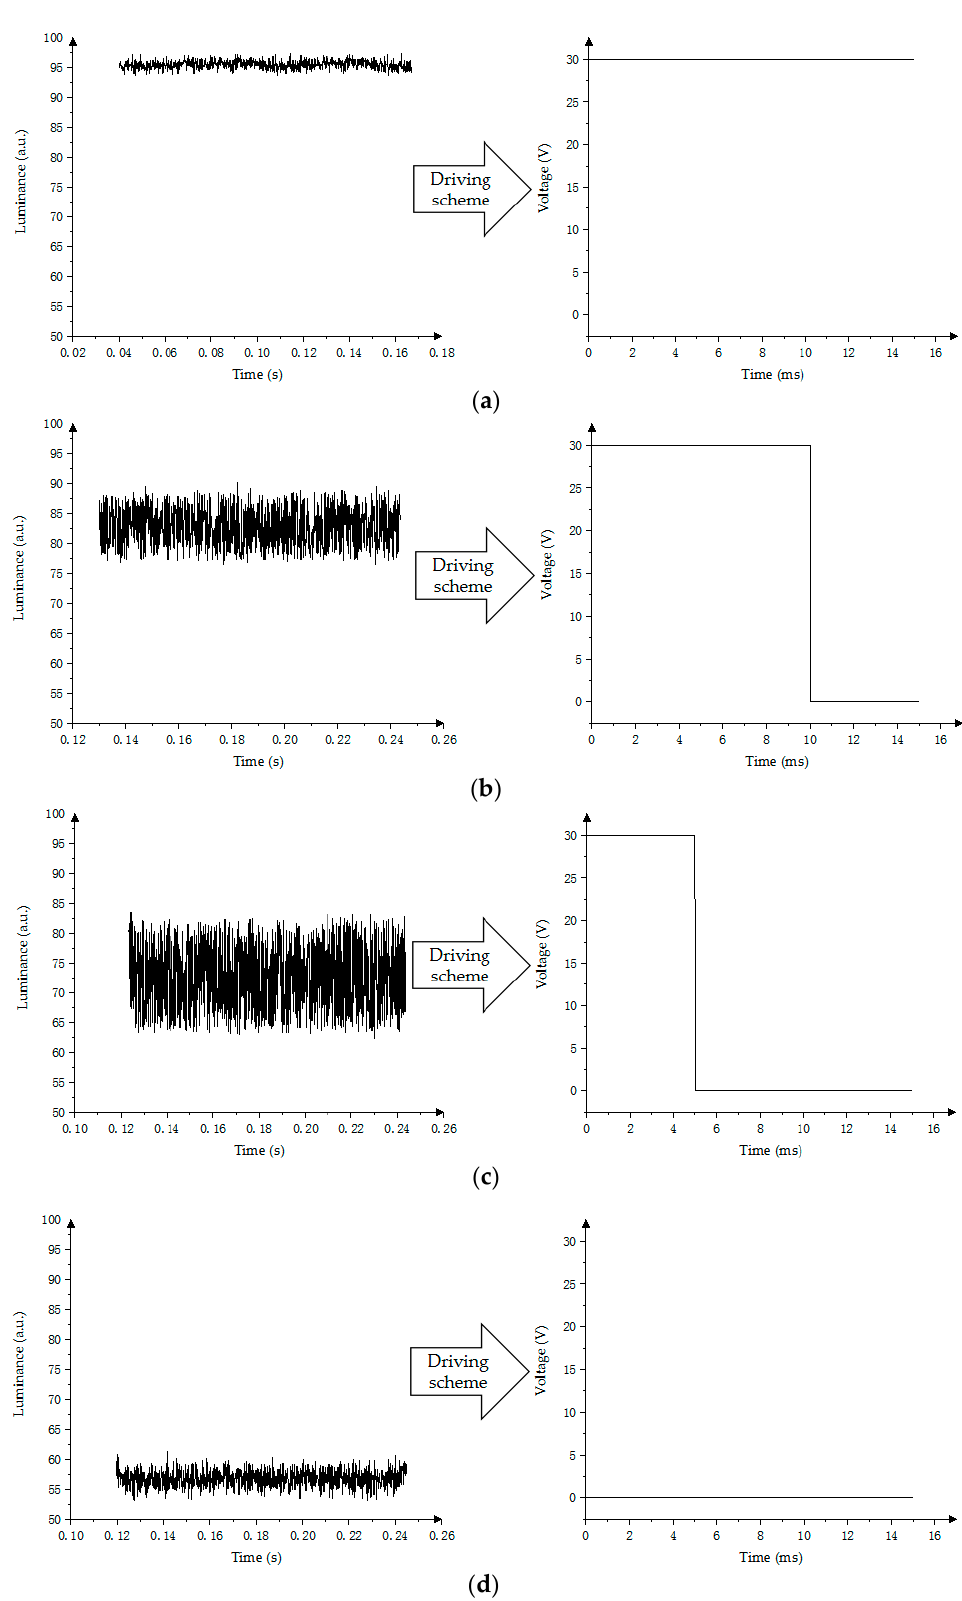
Figure 11. Four-stage driving waveform and its response curve by using PWM scheme. ( a ) First gray scale; ( b ) Second gray scale; ( c ) Third gray scale; ( d ) Fourth gray scale.